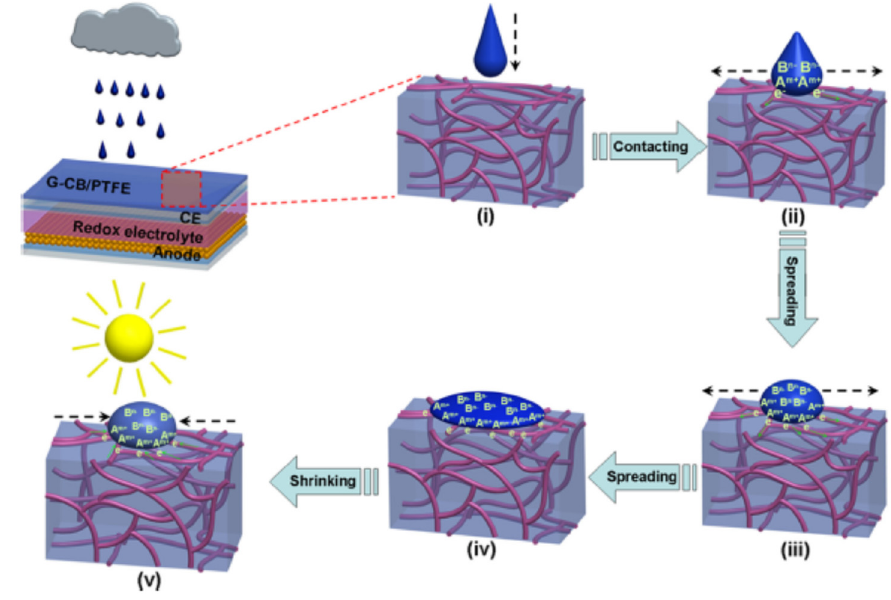
Figure 15. The charge adsorption and transportation pathways during the spreading/shrinking processes for a raindrop on G-CB/PTFE conducting composite of all-weather solar cell. Reproduced with permission from [39] © 2021 Elsevier Ltd. Furthermore, the Na + concentration influence on electric signals was studied: NaCl aqueous solution concentration increased from 0.2 to 2 mol L − 1 . The current and voltage